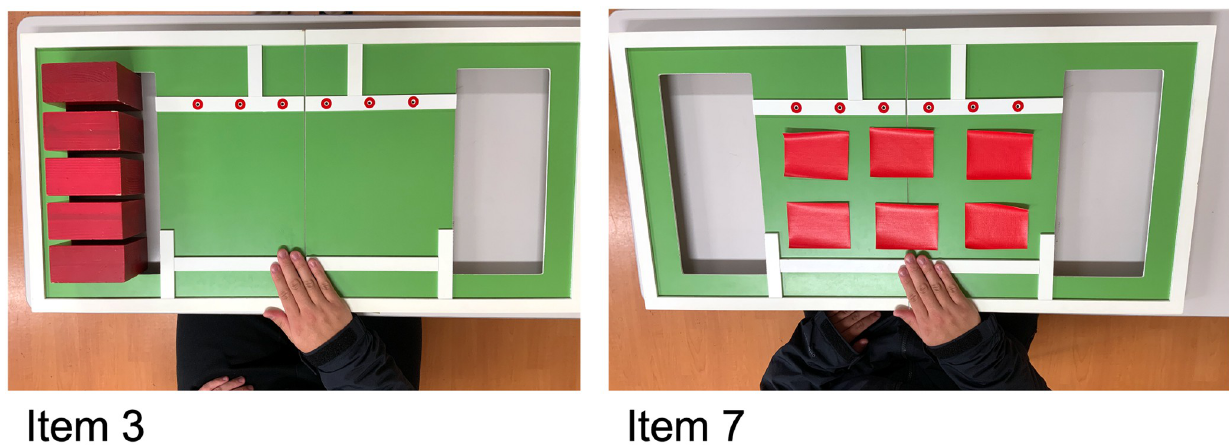
Fig 2. The simple test for evaluating hand function